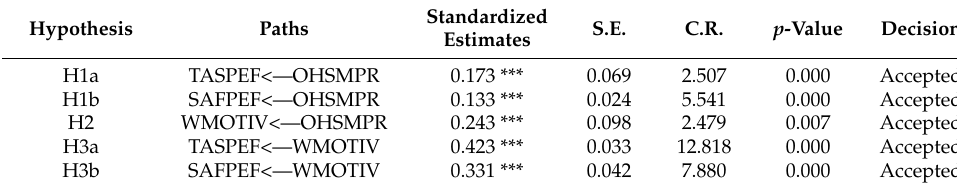
Table 8. Path Estimates of